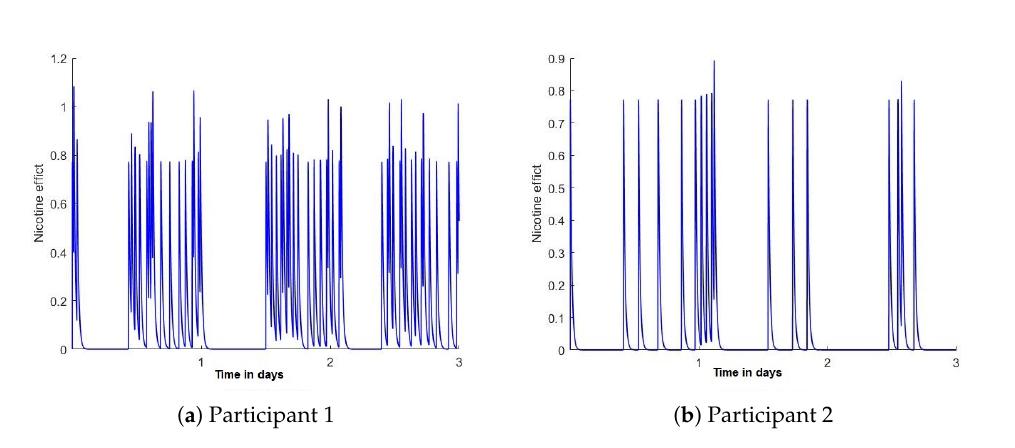
Figure 6. Examples of 3 days of smoking behaviour by two randomly selected participants, as modelled using control theory to represent nicotine levels